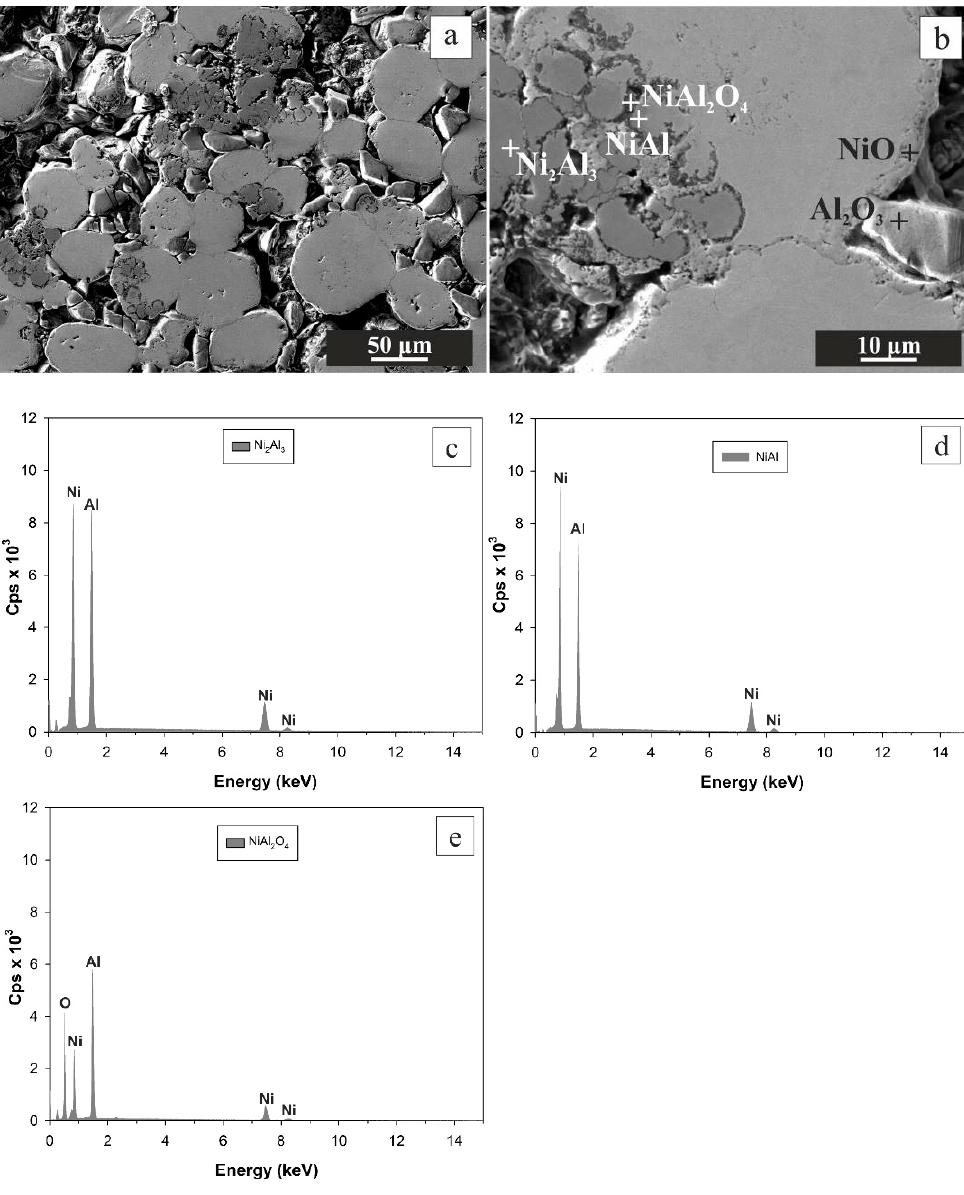
Figure 5. SEM images from the central region of the oxidized CIP green tablet at magnification 300× ( a ) and 1500× ( b ). Thermal oxidation was performed in an oven at the final temperature of 700 °C. The phases, determined by EDS, are denoted by the cross ( b ). EDS spectra were obtained by point analysis in Ni 2 Al 3 (c), NiAl ( d ), and NiAl 2 O 4 ( e ). When the final heating temperature further grew from 700 °C to 800 °C (Figure 6), the relative weight gain was increased up to 5.568 ± 0.051 %, and open porosity was de- creased to 11.87 ± 8 × 10³ % (Figure 2). Concerning chemical composition, neither new phase was generated (Figure 7).